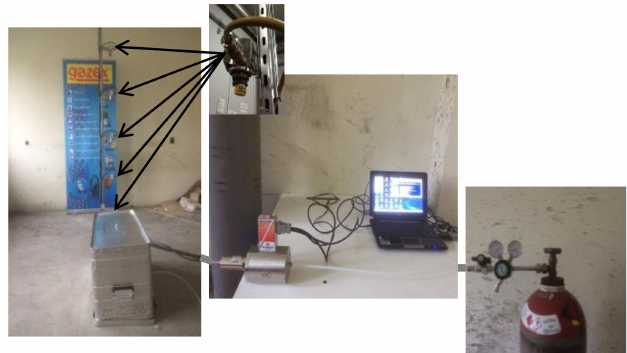
Figure 3. Photo of the measurement layout of hydrogen dispersion.